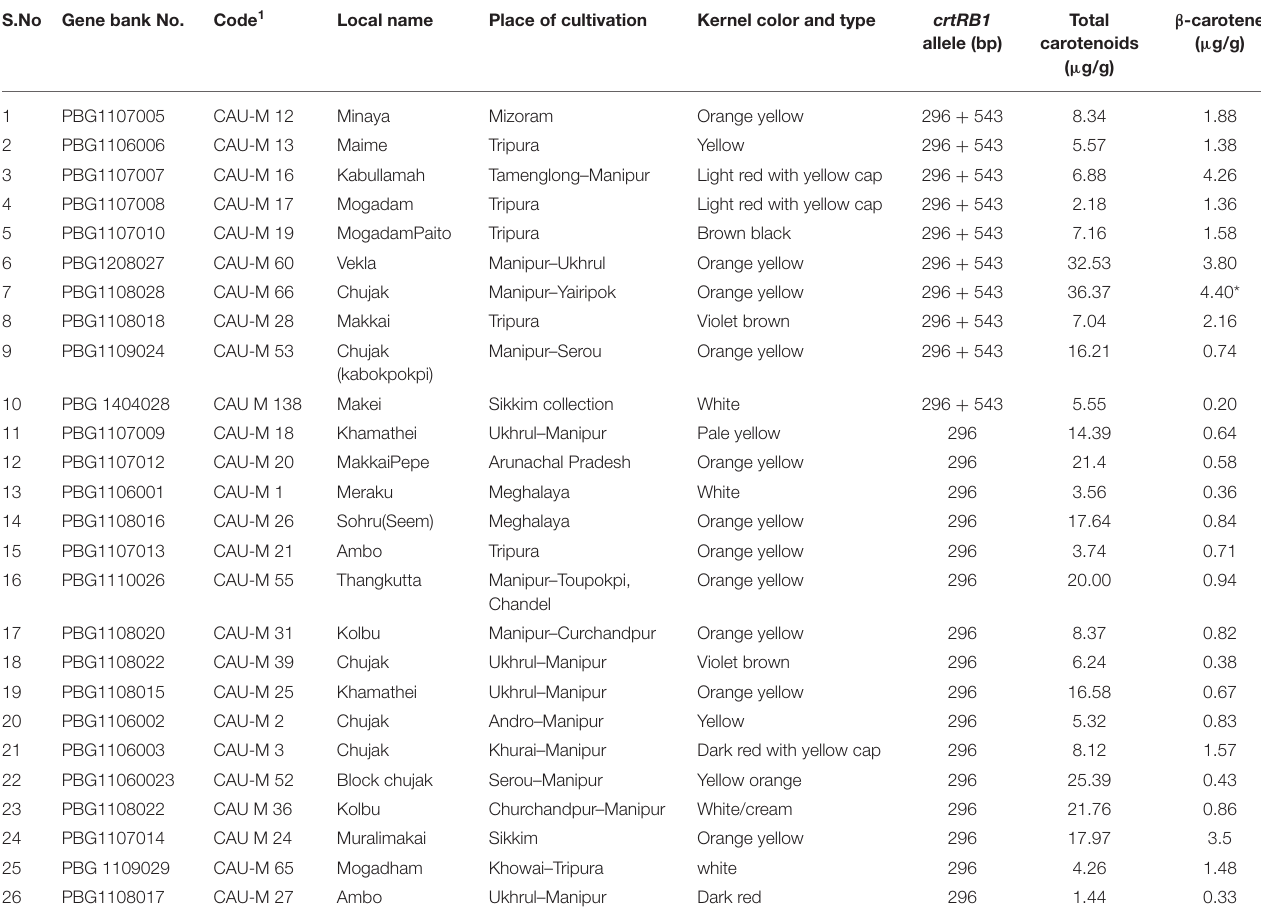
TABLE 1 | Details of crtRB1 allele, total carotenoids, and β -carotene contents in maize landraces from NEHR of India. S.No Gene bank